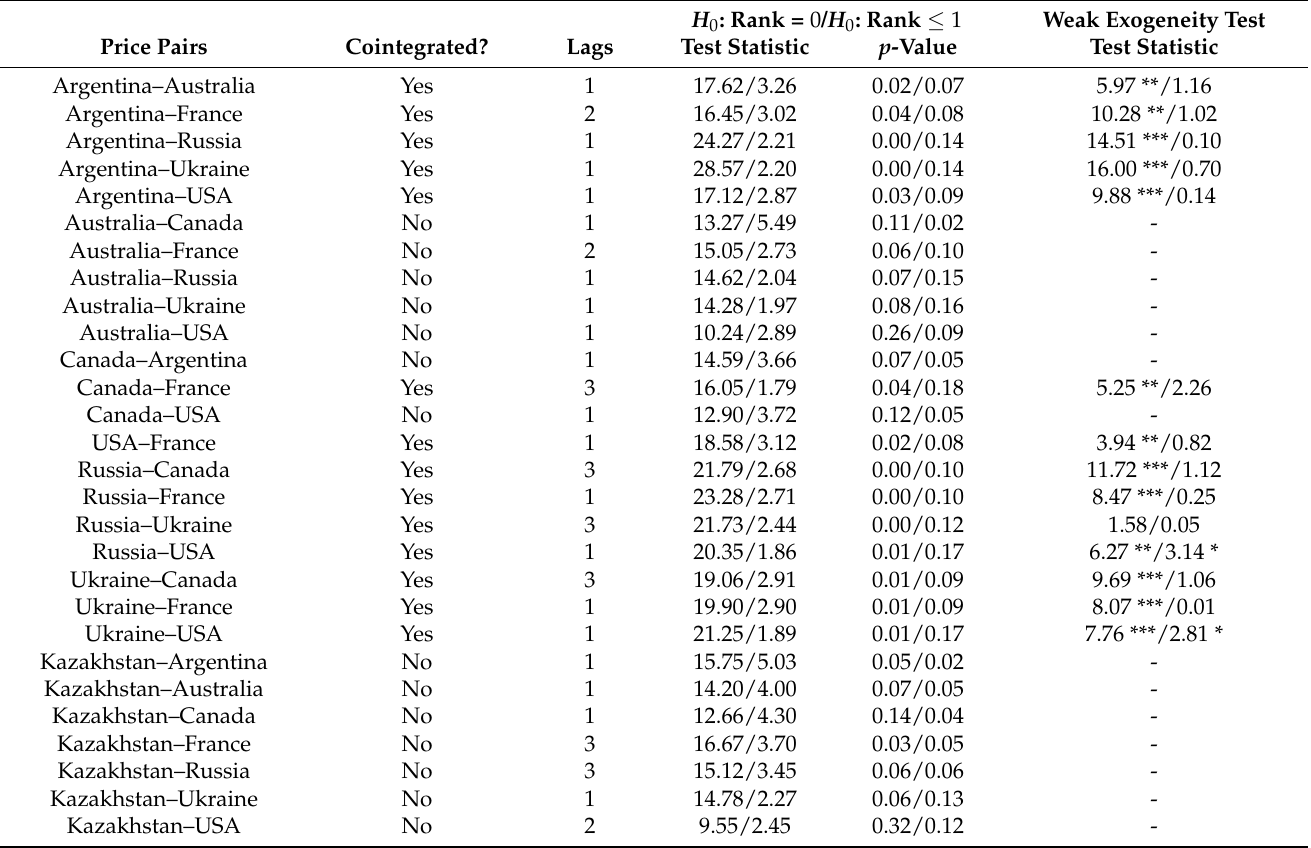
Table 3. Johansen’s test of linear cointegration and weak exogeneity.